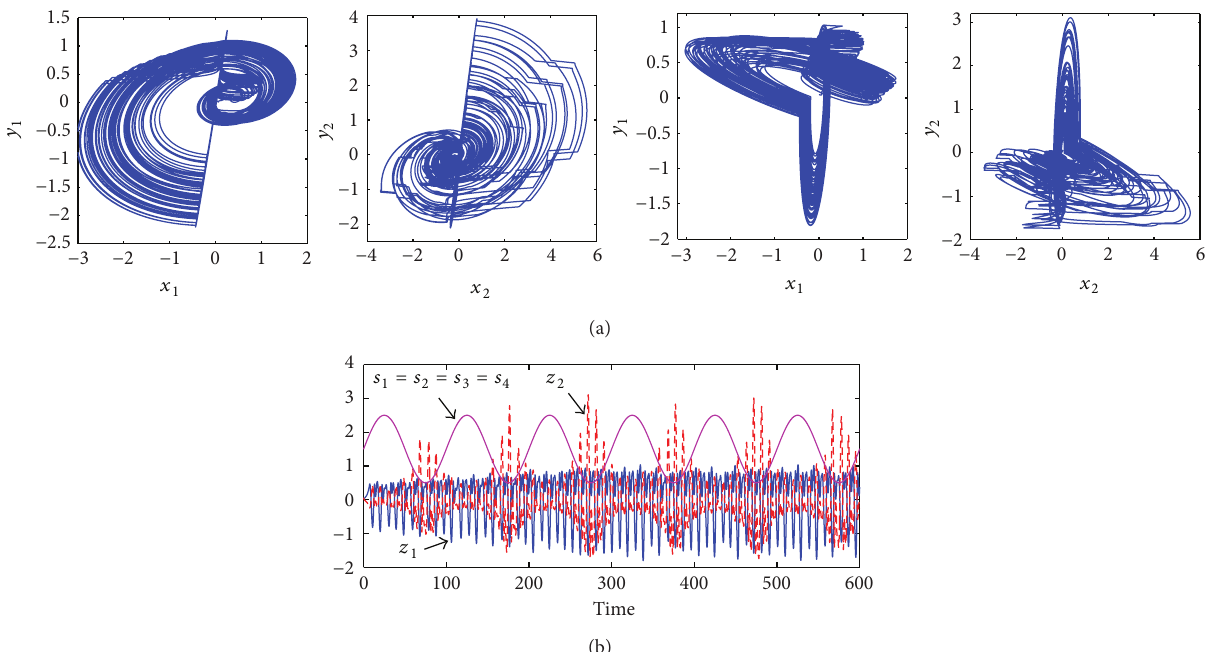
Figure 7: The projection and responses for the amplitude modulation when 𝑠 1 (𝑡) = 𝑠 2 (𝑡) = 𝑠 3 (𝑡) = 𝑠 4 (𝑡) = 1.5 + sin (0.02𝜋𝑡)